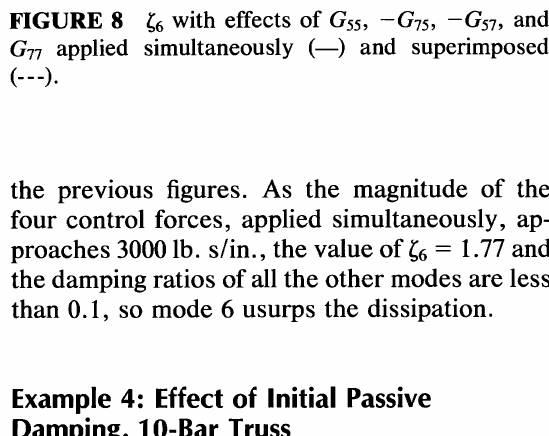
FIGURE 6 WD5, WD6, and WD8 versus G 77• FIGURE 8 ~6 with effects of G 55, -G 75, -G 57, and G 77 applied simultaneously (-) and superimposed